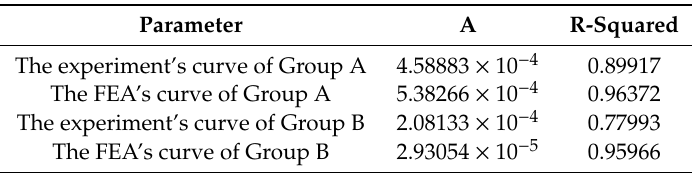
Table 7. Parameter analysis of the quadratic curve